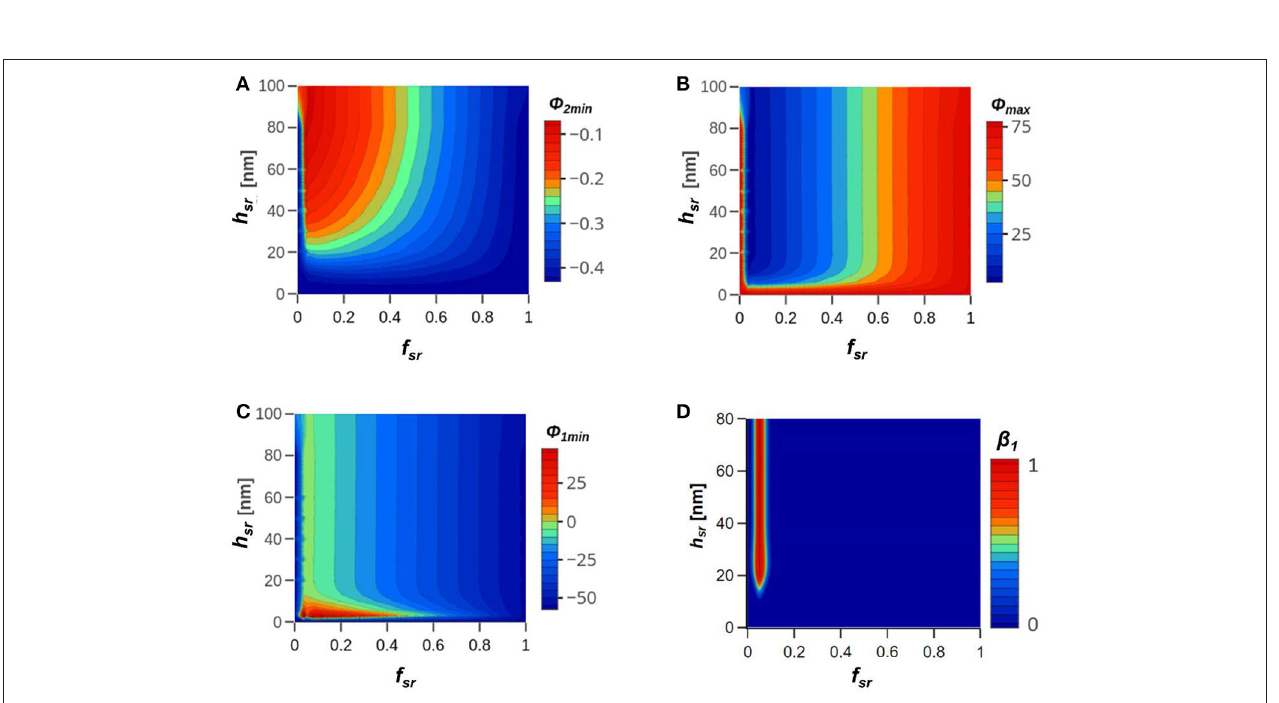
22 and 49, respectively. Table 1 gives a summary of all parameters. − −